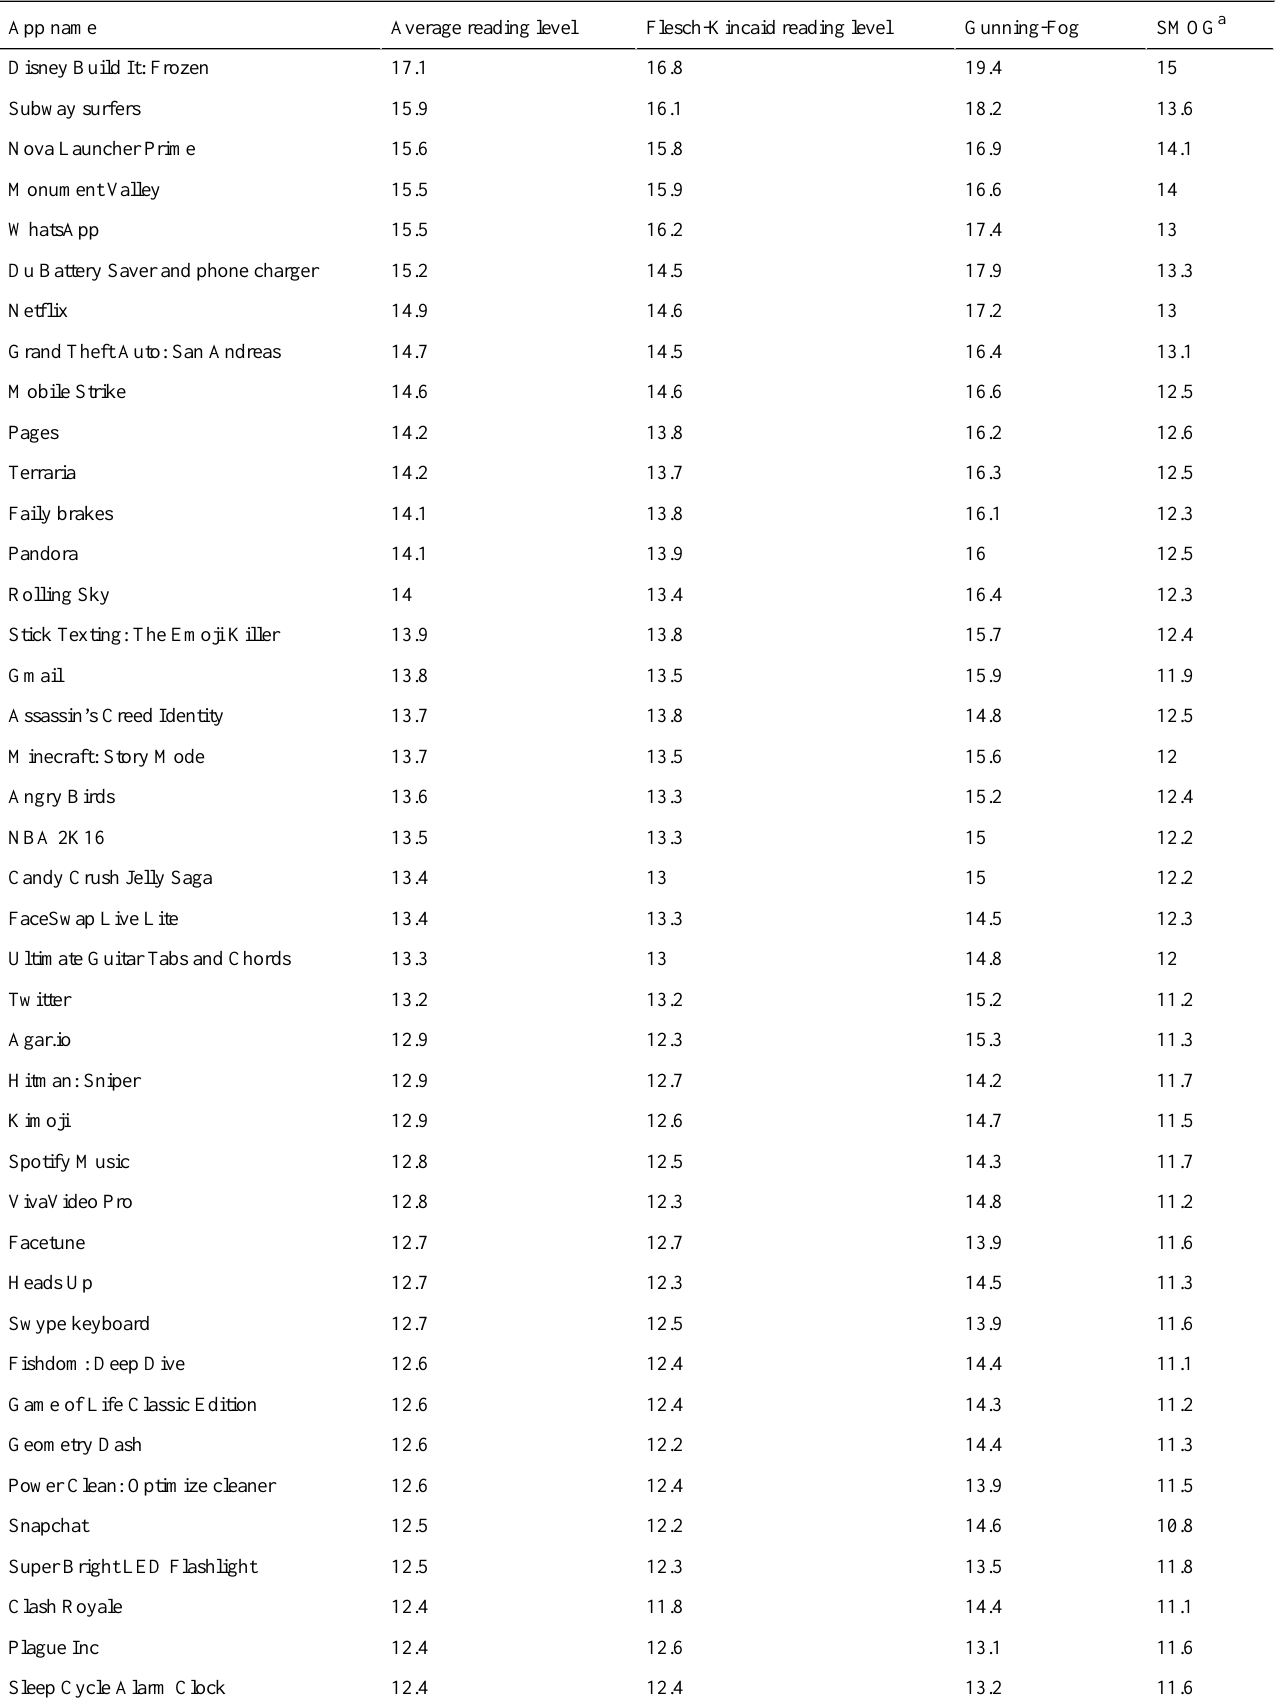
Table 1. Flesch-Kincaid, Gunning-Fog, simplified measure of Gobbledygook (SMOG), and average reading grade levels (RGLs) for all apps included in the analysis. The average reading level column is the average of Flesch-Kincaid, Gunning-Fog, and SMOG